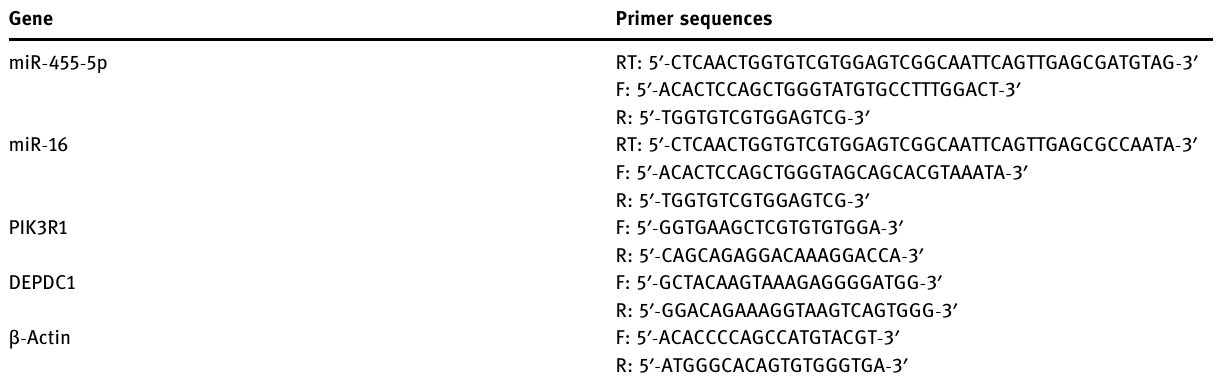
Table 1: Primer sequences Gene Primer